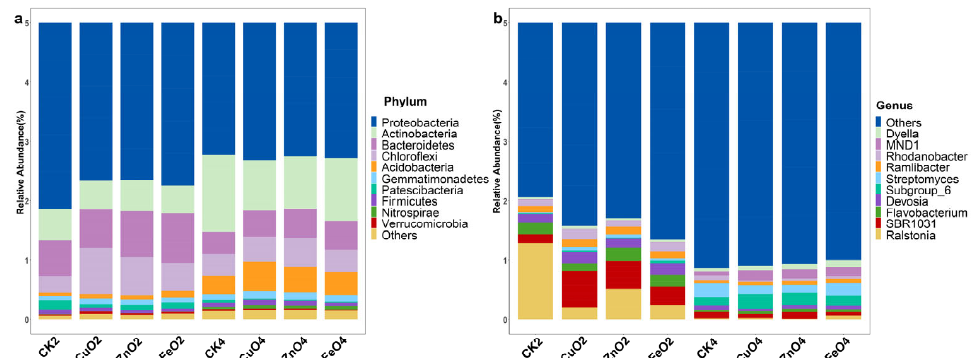
Figure 5. Relative abundance distribution at the level of microbial phylum-level ( a ) and genus-level ( b ) in the rhizosphere. Abbreviation: 2nd week of nanoparticles treatment (CK2, CuO 2 , ZnO 2 , and FeO 2 ), 4th week of nanoparticles treatment (CK4, CuO 4 , ZnO 4 , and FeO 4 ).